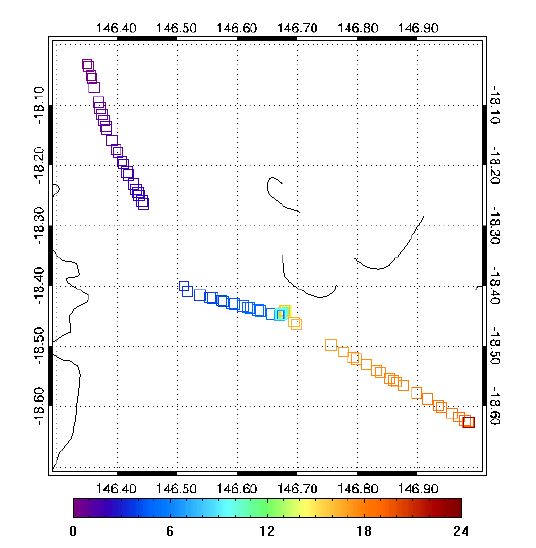
Figure 7. Matchups of cruise track on 12 th October 2016, colors represent local time in hours.